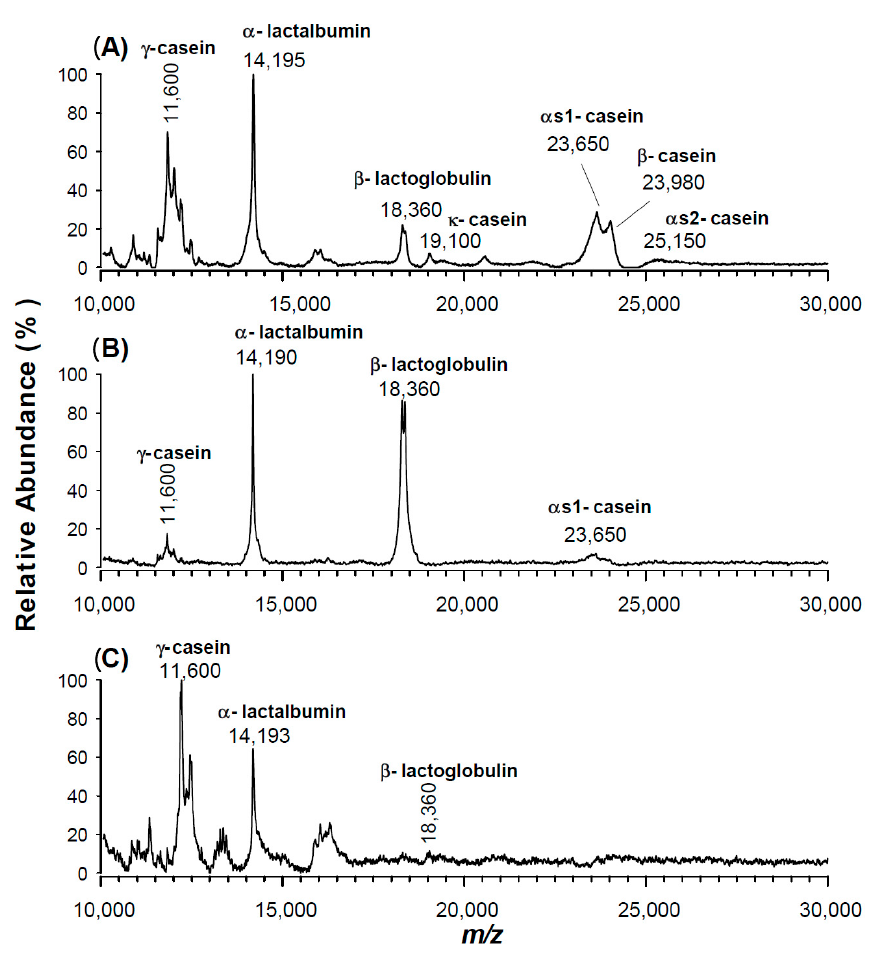
Figure 5. Positive MALDI-TOF MS spectra of an aqueous extract of cow milk proteins after mixing with ( A ) CPPA, ( B ) CHCA or ( C ) CClCA as the matrix. The identified proteins are labelled in the